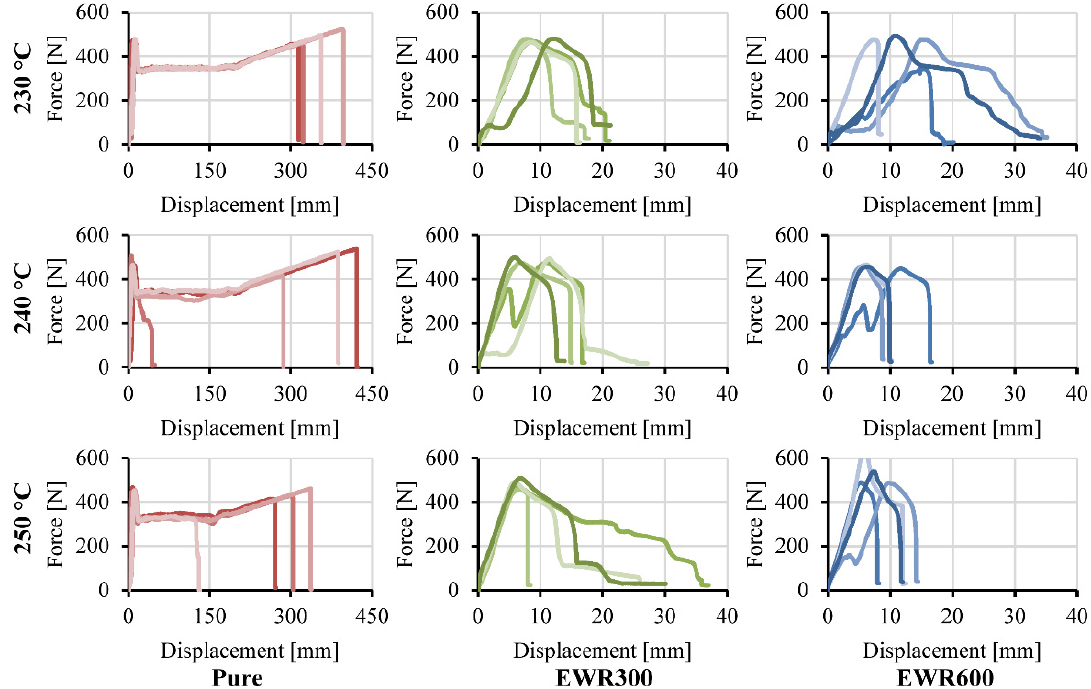
Figure 12. Force-displacement curves of the tensile unfoamed samples prepared at different injection temperatures. The different color shows different samples.